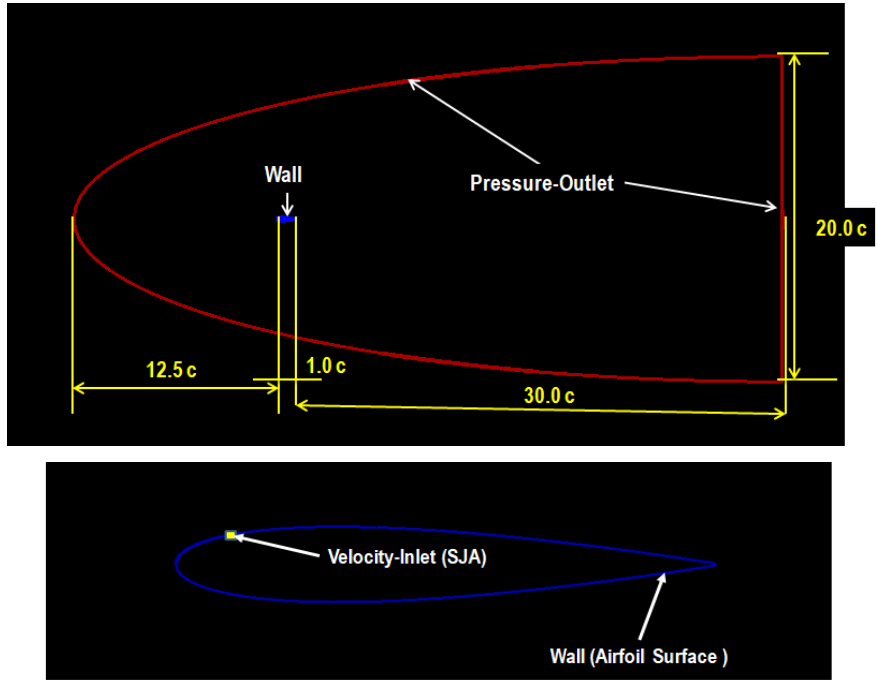
Figure 1. URANSSimulation, schematicofthecomputationaldomain, airfoillocation, Figure 1. URANS Simulation, schematic of the computational domain, airfoil location, and boundary conditions.